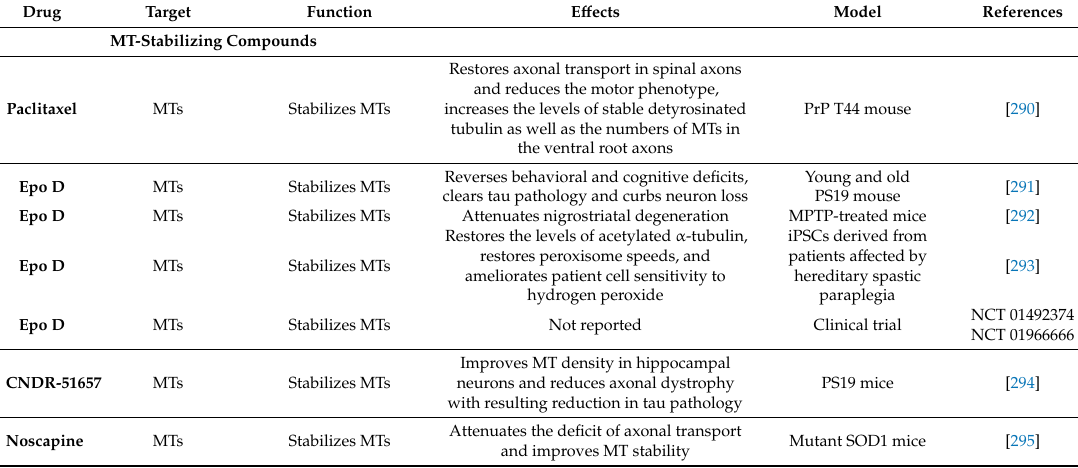
Table 2. List of most relevant MT-targeting